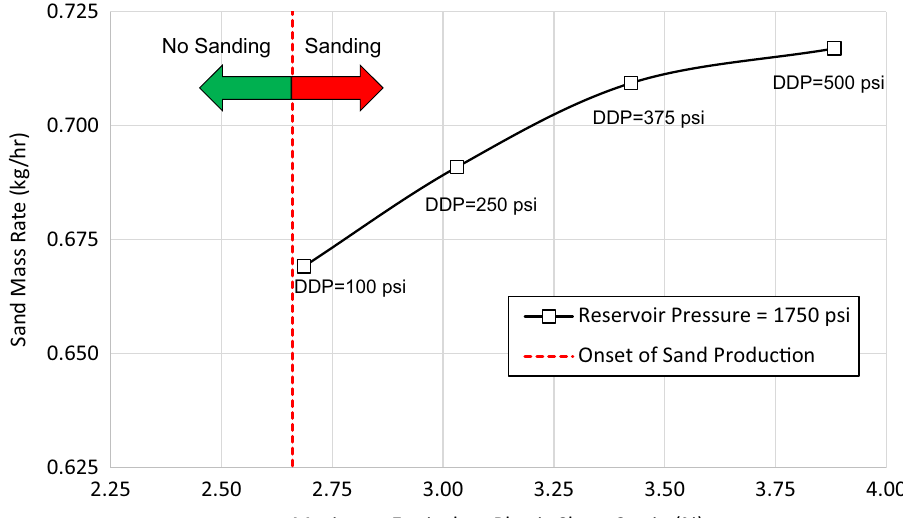
Fig. 31 Produced sand